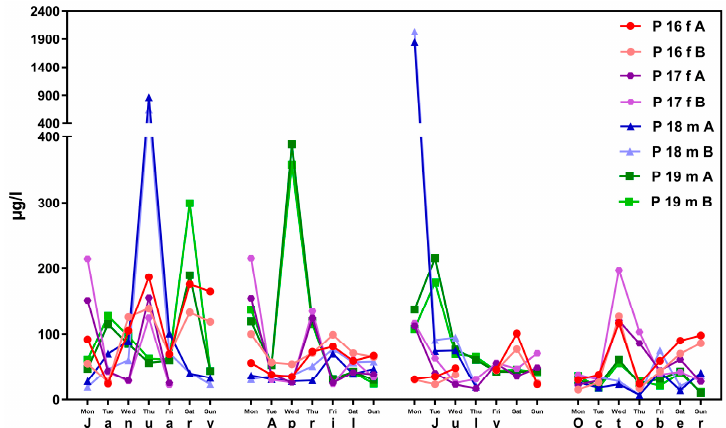
Figure 3. Concentration distribution of ∑ 5OH-MEHP + 5oxo-MEHP (A) und 5cx-MEPP (B) in morning urine of 58 female (f, red symbols) and 51 male (m, blue symbols). Subjects aged between 15 and 30 years from the general population (“Tübingen Survey”). X-axis: urine samples (from female and male participants) in arbitrary order.